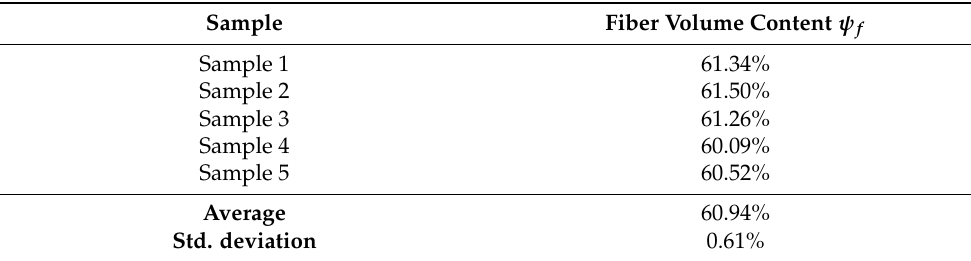
Table 2. Measured fiber volume